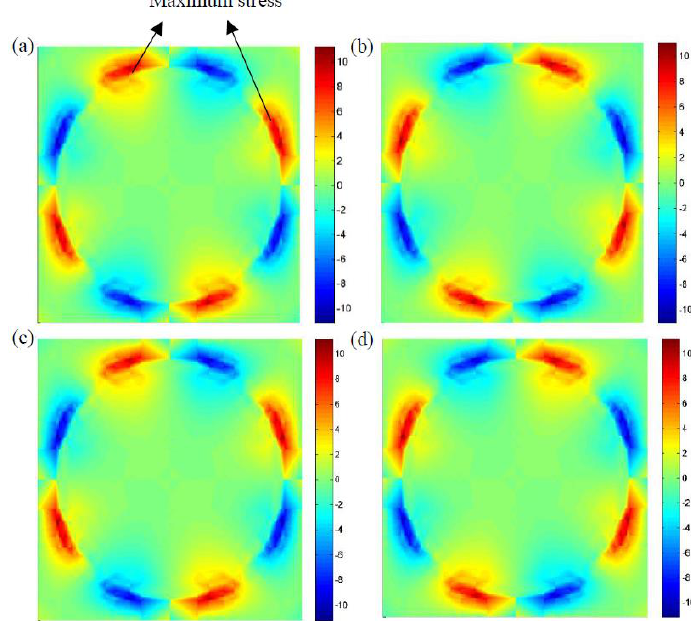
Figure 11. Microscopic stress distributions, σ 23 , of the composites ( a ) with temperature variation at 0.5 s, ( b ) without temperature variation at 1.5 s, ( c ) with temperature variation at 0.5 s, and ( d ) with temperature variation at 1.5 s.